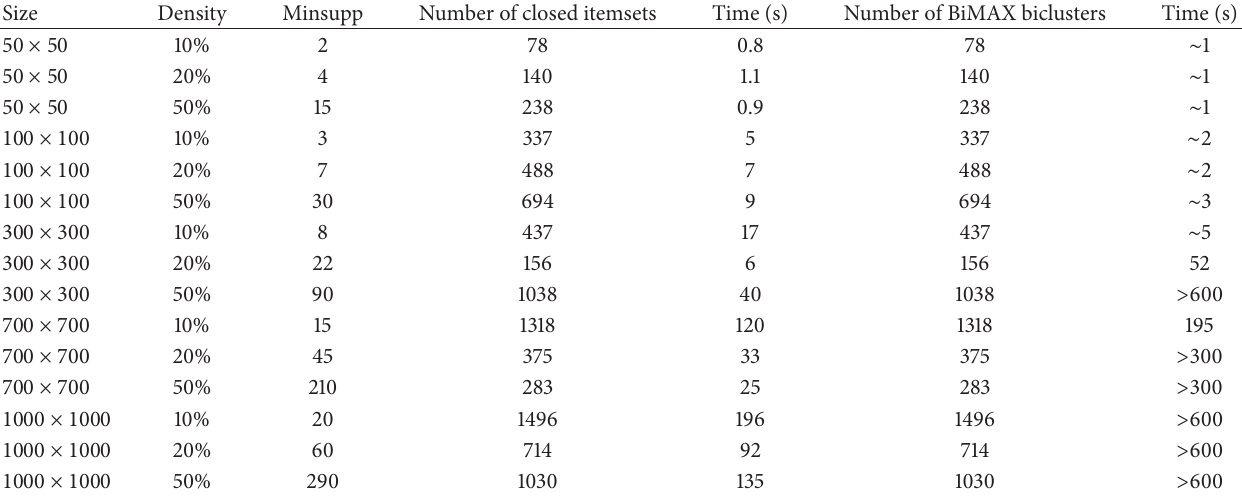
Table 1: Performance test using synthetic data.